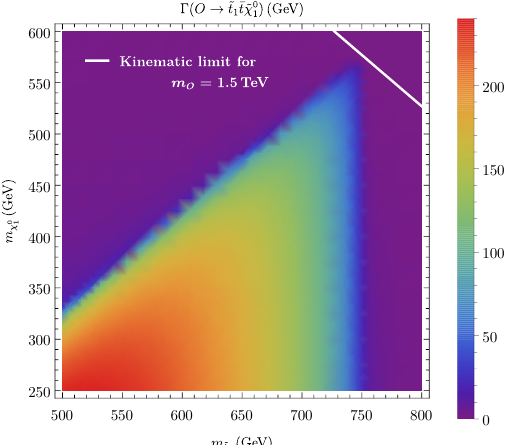
Figure 7. Partial width of decay of a scalar sgluon of mass m O = 1.5 TeV to a light stop, a top quark, and the Higgsino LSP.